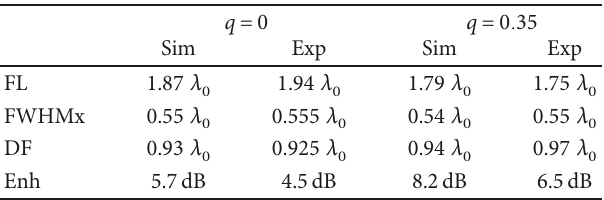
Table 1: Results of the focusing properties of the metalenses with reference phase and phase reversal. The experimental and numerical values are given at frequencies of 55.5GHz and 55GHz,